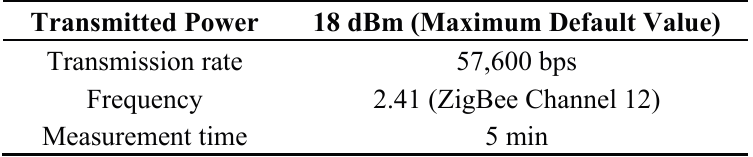
Table 4. Configuration of the parameters of the XBee Pro wireless devices to measure the received power level.